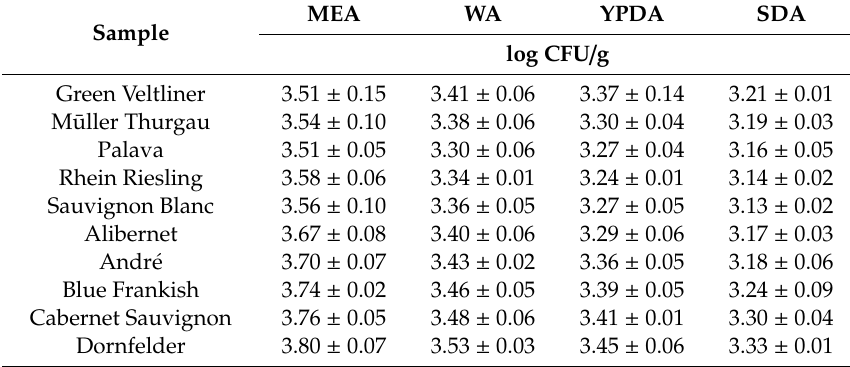
Table 4. Yeast counts in “federweisser” on di ff erent